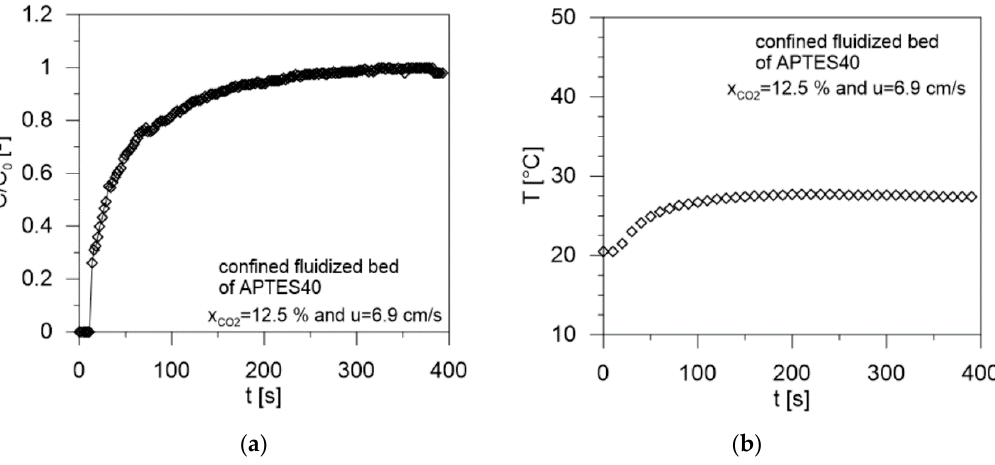
Figure 13. Adsorption test for APTES40 in a confined bed at u = 6.9 cm/s. Mass of adsorbent: 100 g. ( a ) Breakthrough curve; ( b ) temperature trend.